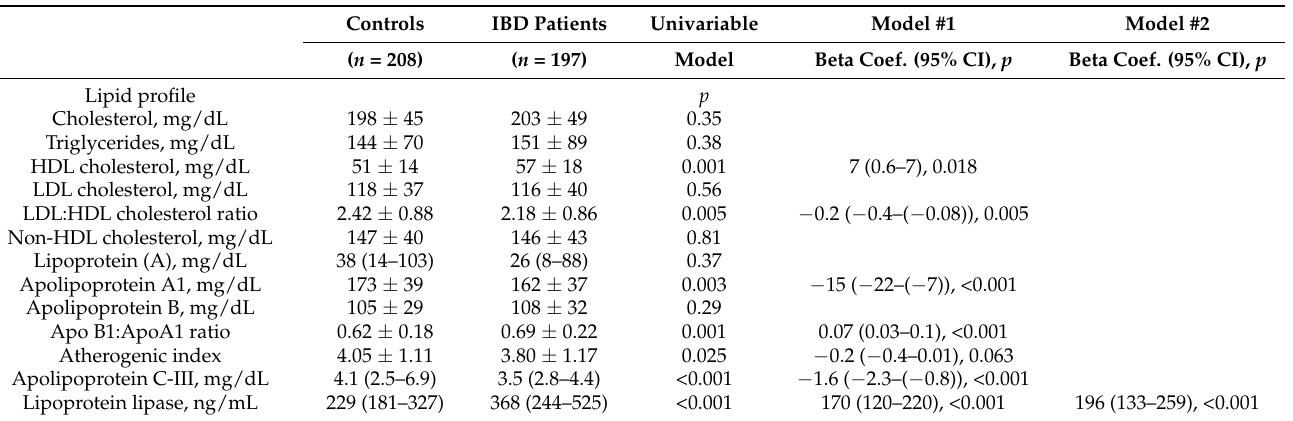
Table 3. Multivariable analysis of the differences in lipid profile and LPL between IBD patients and